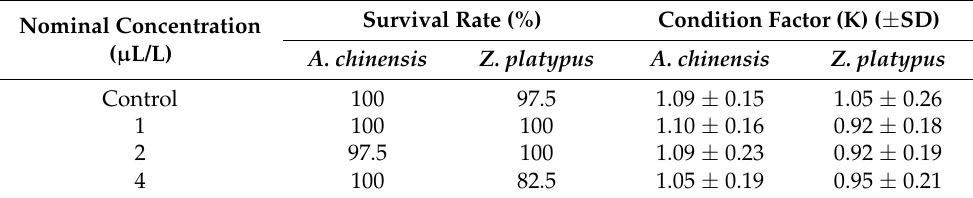
Table 6. Survival rates and condition factors in Z. platypus and A. chinensis, following benzyl chloride exposure . Nominal Concentration (μL/L)